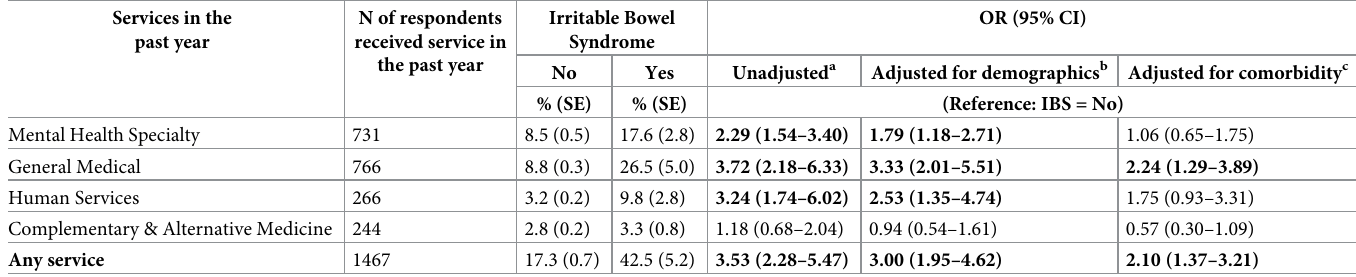
Table 6. Health-care services obtained in the past year. Services in the past